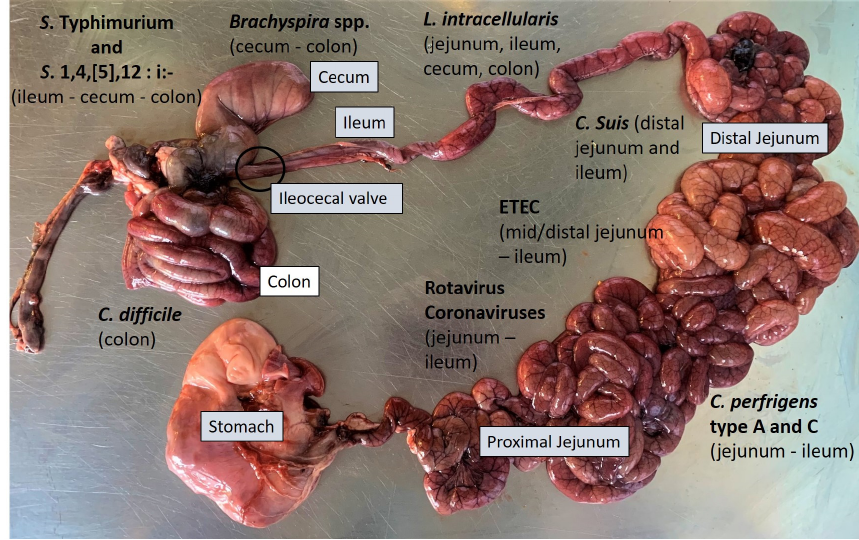
Figure 3. Intestine of pig. Main distribution of the aetiological agents and related lesions.